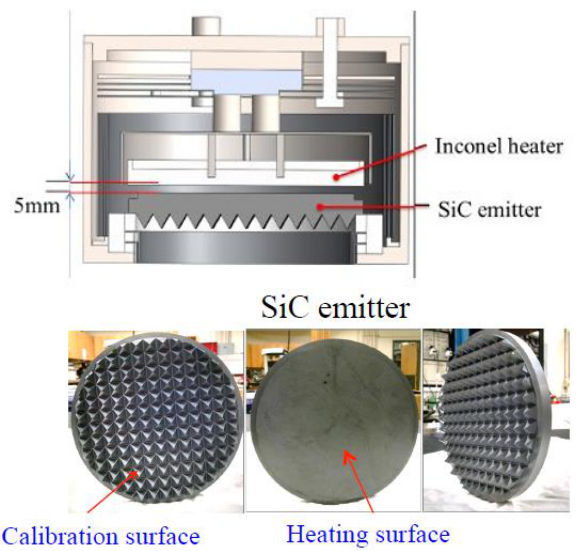
Fig. 6. Hot Calibration Source basic design (top) and SiC emitter (bottom) .